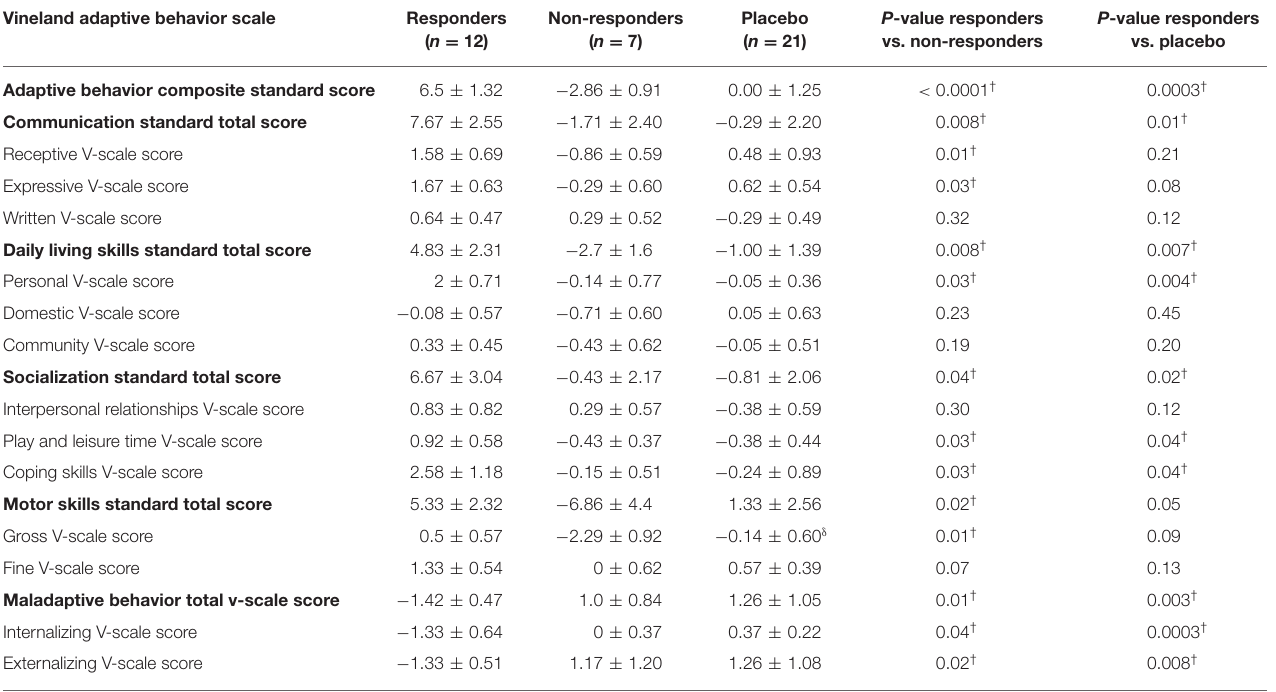
TABLE 5 | Changes in VABS-II scores in responders, non-responders, and placebo groups. Vineland adaptive behavior scale Responders